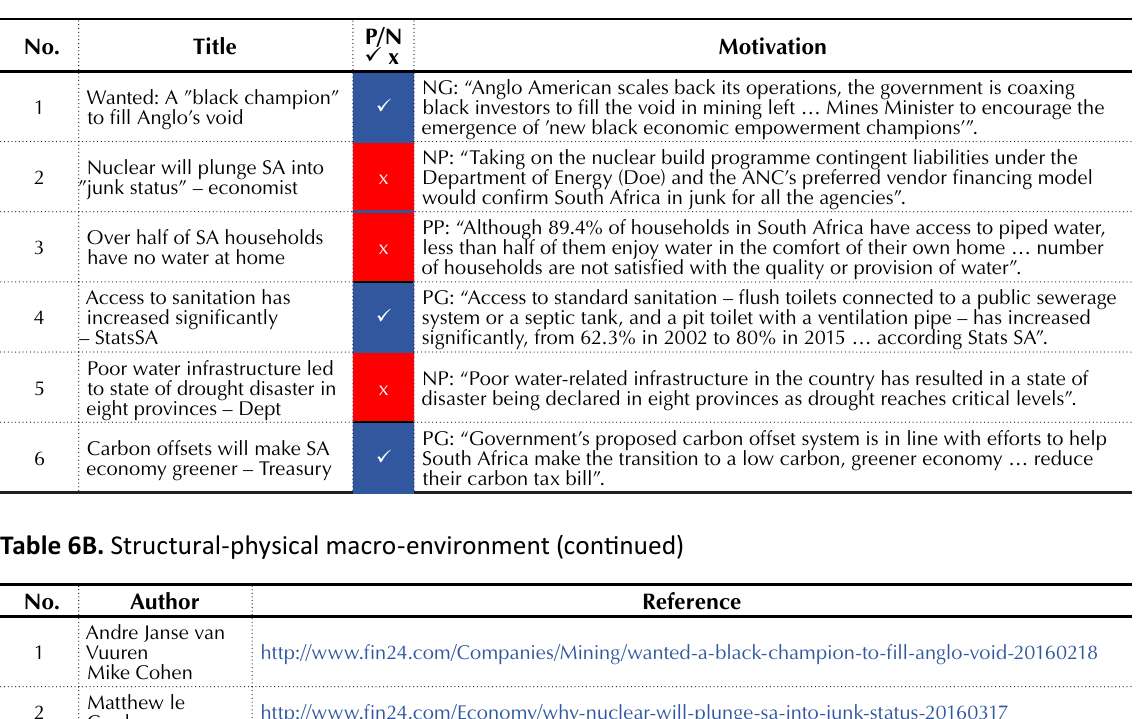
Table 6A. Structural-physical macro-environment (January-June 2016)